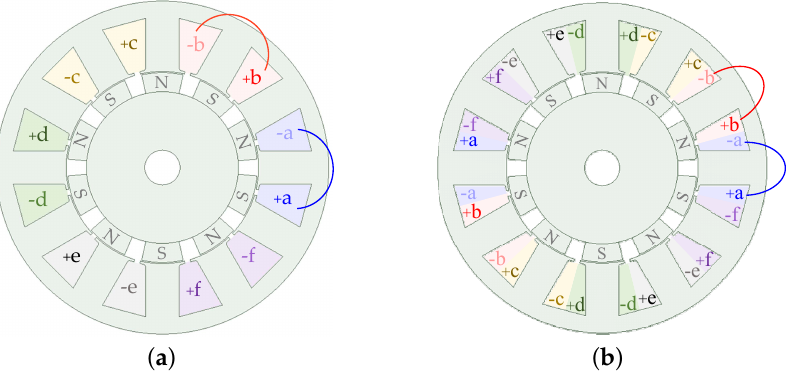
Figure 6. Difference between single- and double-layer FSCWs, for a six-phase machine with symmet- rical WSA. ( a ) Single layer. ( b ) Double layer.